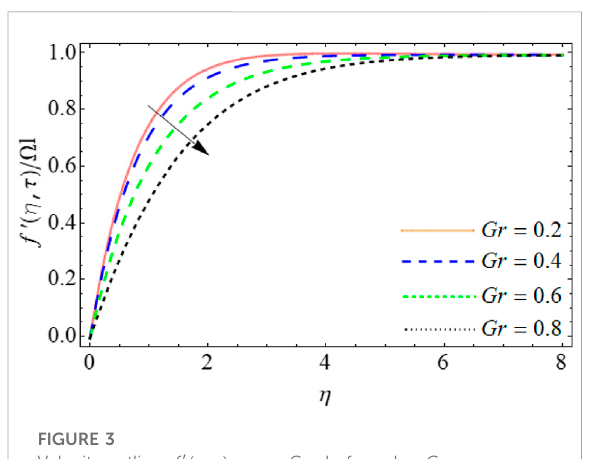
FIGURE 5 Velocity outlines f ′ ( η , τ ) versus parameter τ